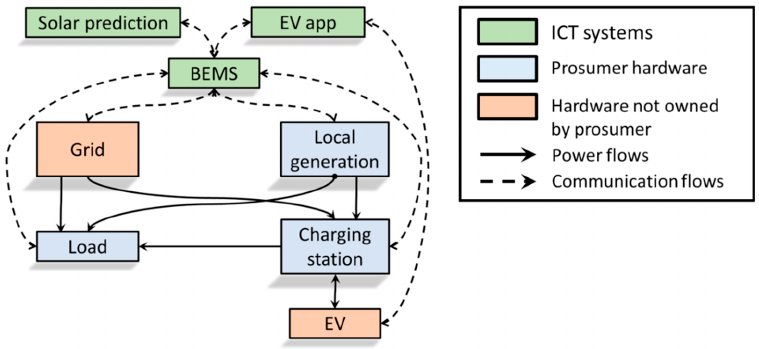
Figure 1. Schematic representation of the power flows and data communication between the proposed prosumer and EVs that are involved as temporary energy storage.